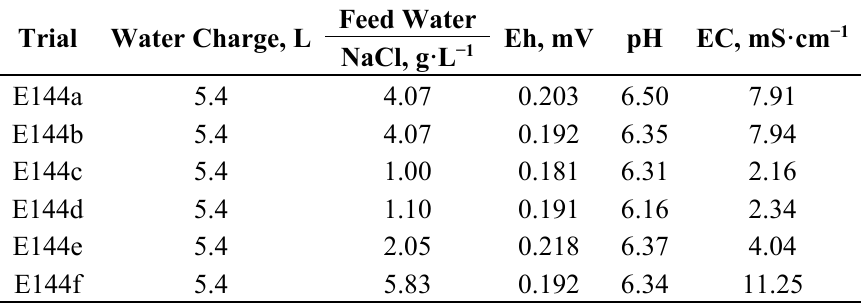
Table C9. ZVM TPA Example (Trial E144): Feed Water Composition.